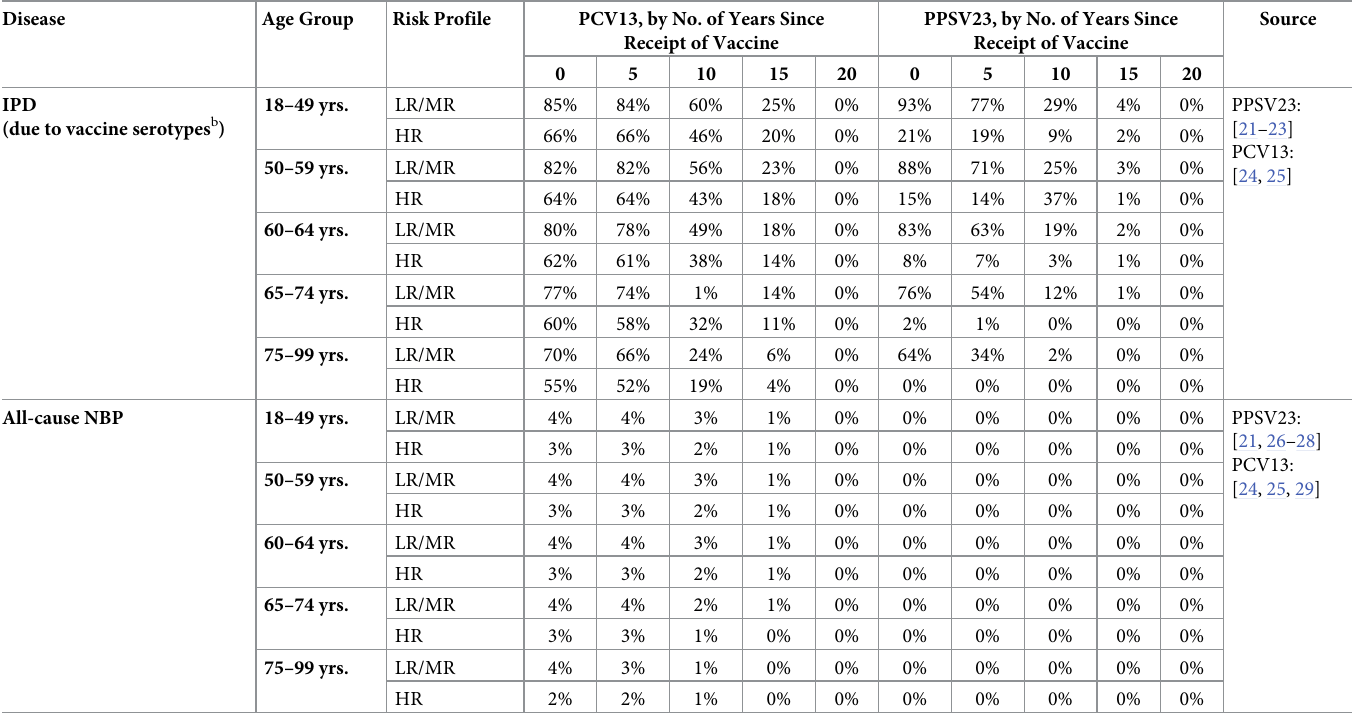
Table 2. Effectiveness of PCV13 and PPSV23 a